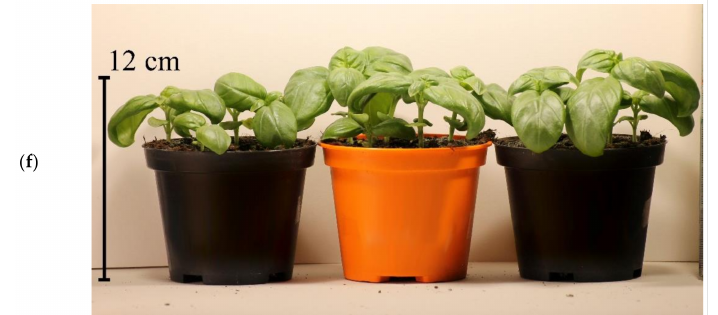
Figure 4. Basil plants at the end of the growth test: ( a ) Sample 6, ( b ) Sample 12, ( c ) Sample 19, ( d ) Sample 2, ( e ) Sample 8, and ( f ) Sample 15. All the sample numbers are referred to in Table